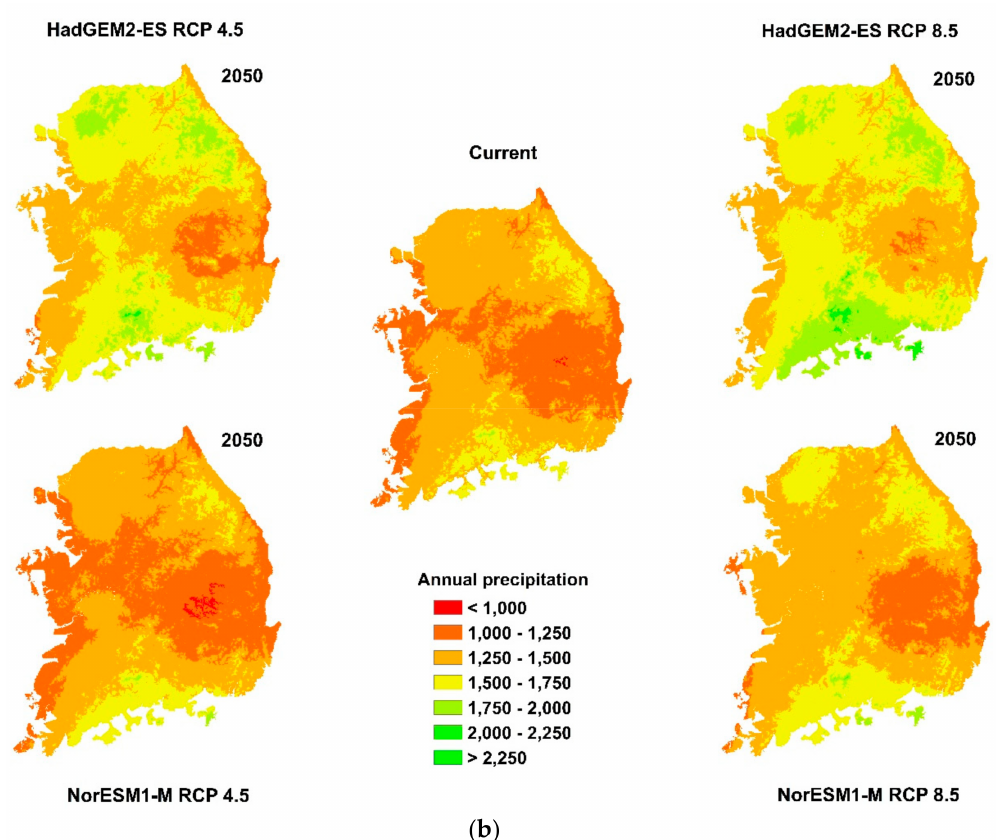
Figure 3. Current climates and 2050 climate projections under four climate scenarios for South Korea: ( a ) Annual average minimum temperature; ( b ) Annual